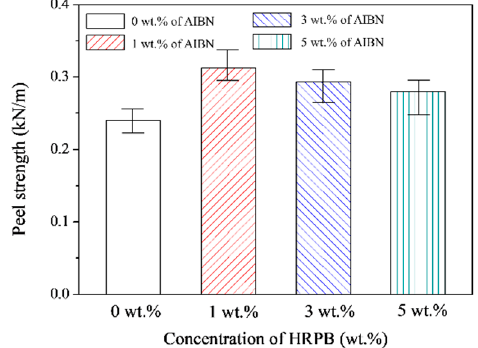
Figure 5. Effect of radical initiator content on the peel strength of EPDM-B-15-based CPP/Al foil